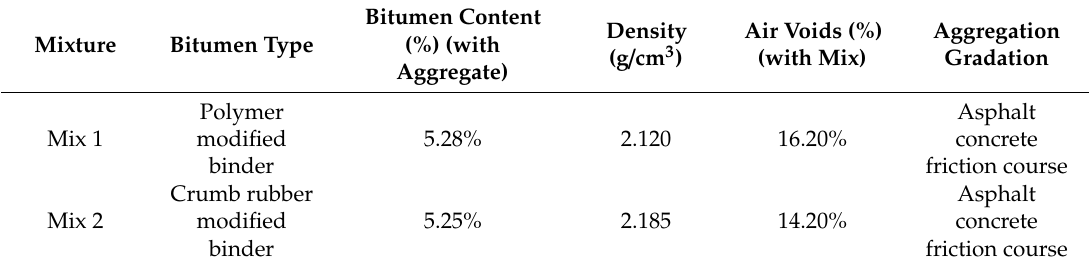
Table 3. Design parameters of the mixtures.